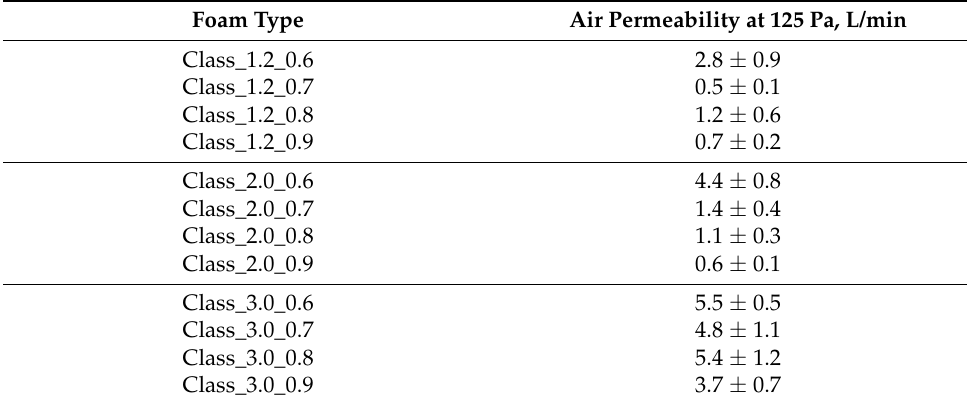
Table 7. The air permeability of foam samples depending on I NCO and water content. Foam